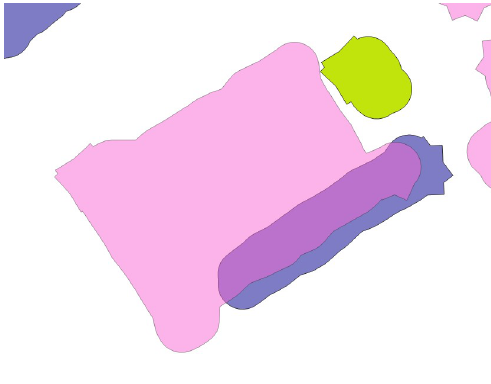
Figure 9: Overlapping areas of different level